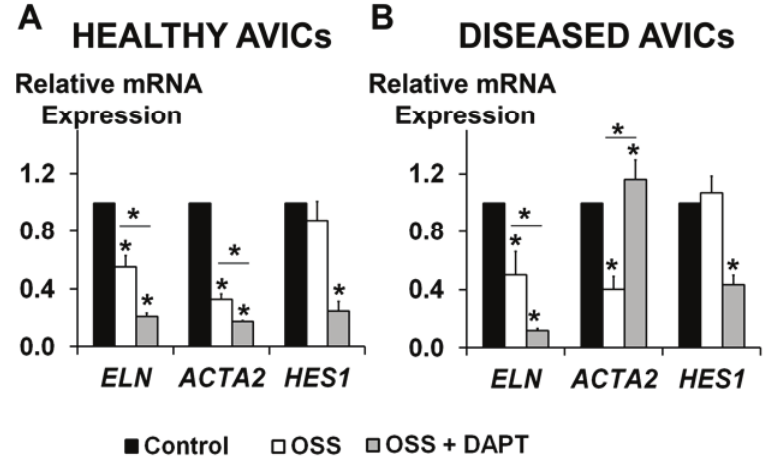
Figure 5. ELN and ACTA2 expression changes in response to OSS and NOTCH LOF in human AVICs. In both healthy ( A ) and diseased ( B ) AVICs, OSS exposure resulted in significantly decreased ELN and ACTA2 expression, while no effect of OSS on HES1 was observed. In healthy AVICs, a combination of OSS and NOTCH LOF (DAPT treatment) resulted in further inhibition of ELN and ACTA2 expression, and a decreased HES1 expression. In contrast, in diseased cells, a combination of OSS and NOTCH LOF had the opposite effect on ACTA2 than either OSS or NOTCH LOF treatment alone, resulting in significantly higher ACTA2 expression levels for OSS with NOTCH LOF group, as compared to the controls. At the same time, the combination of OSS and NOTCH LOF in the diseased cells resulted in further decreases in ELN and HES1 expression levels as compared to NOTCH LOF alone, which was similar to the responses in healthy